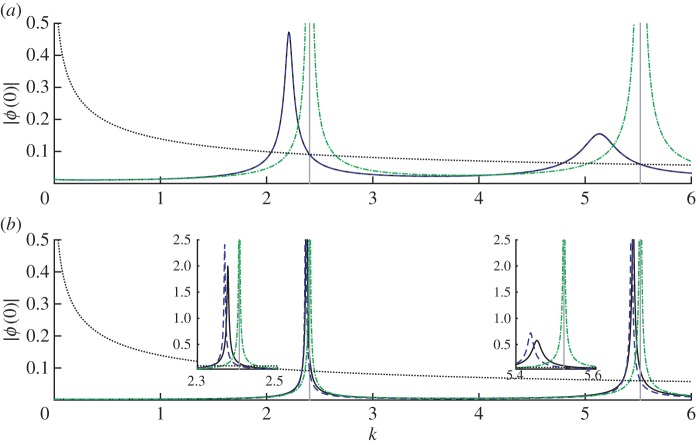
Amplitudes at z=0 for the wave problem for disc-shaped wires arranged around the unit circle, for varying wavenumber k. Corresponding field plots for particular wavenumbers are shown in figure 5. Parameters are M=30, z0=2 and (a) δ=0.01, (b) δ=0.1. Solid black lines show the numerical solution and dashed blue lines show the ‘thin-wire’ asymptotic result (in (a) this is indistinguishable from the numerical solution), dotted-dashed green lines show the ‘thick-wire’ asymptotic result (without correcting for resonance), and dotted black lines shows the unshielded (free-field) solution. Vertical lines indicate the unperturbed resonances for the unit circle corresponding to axisymmetric modes (two asymmetric modes are also excited in this wavenumber range, but have zero amplitude at the origin). Insets in the lower panel show enlargements around the peaks. (Online version in colour.)